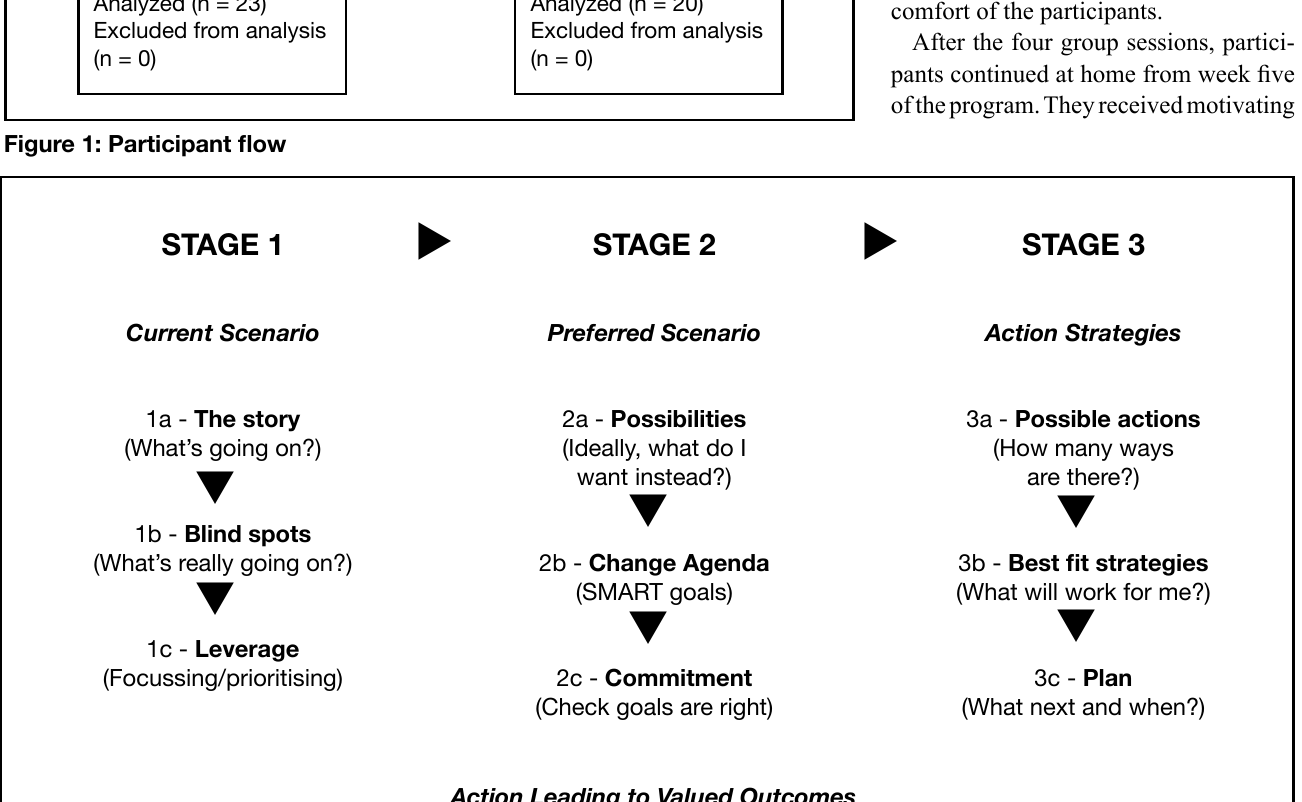
Action Leading to Valued Outcomes figure 2: diagram of the Skilled helper model (egan 1998)